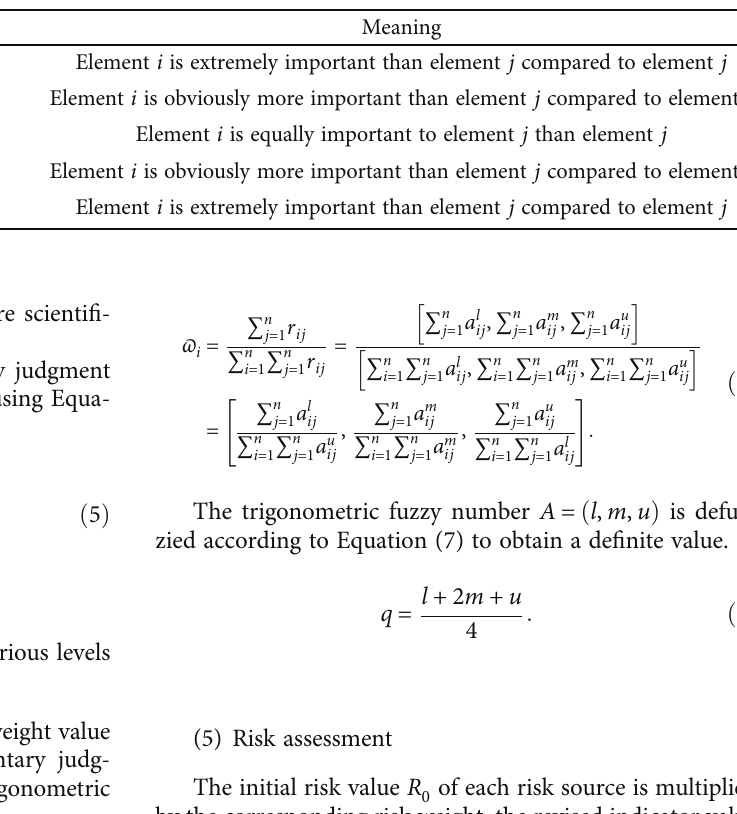
Figure 2: Risk assessment fl owchart. Table 1: Fuzzy scale values and